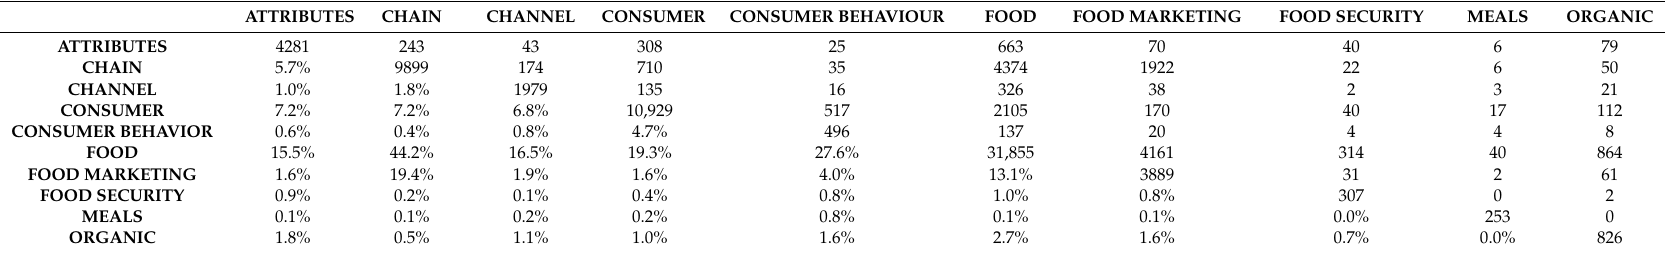
Table A10. Food dimension categories